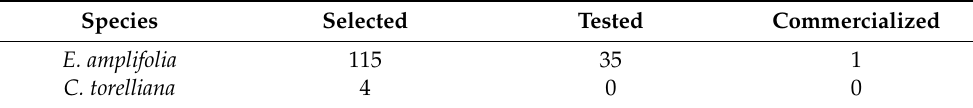
Table 2. Numbers of Eucalyptus amplifolia and Corelliana torelliana clones selected, tested, and com- mercialized from